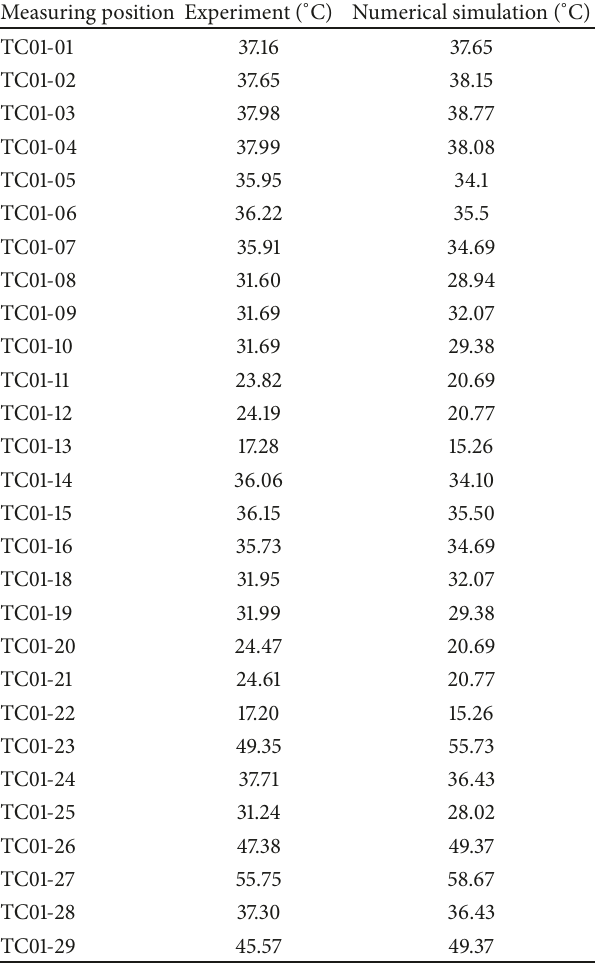
Table 5: The temperature contrast of experiment and simulation at the support bottom and